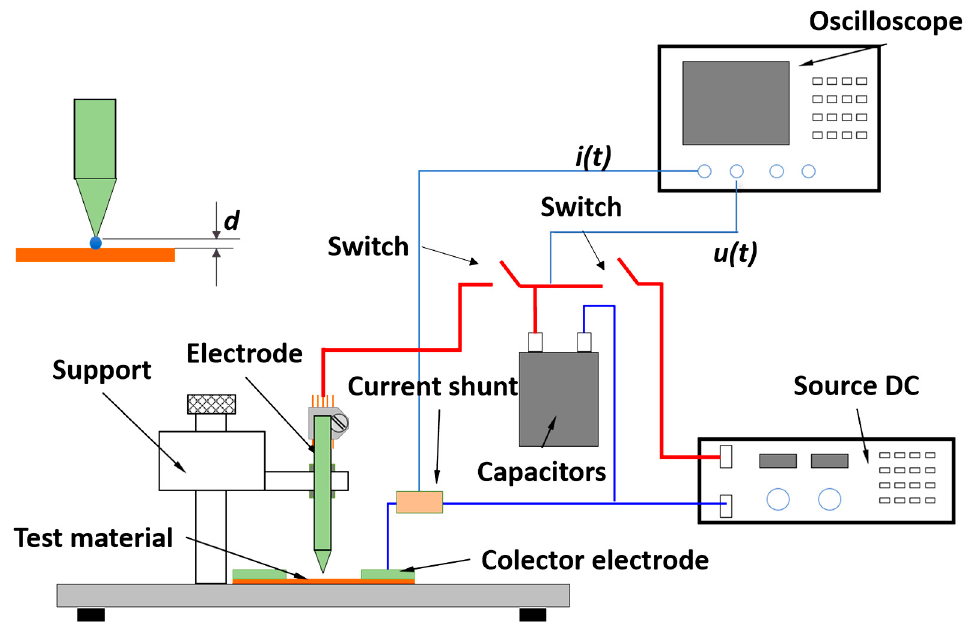
Figure 5. Diagram of a lightning strike system developed by the authors.